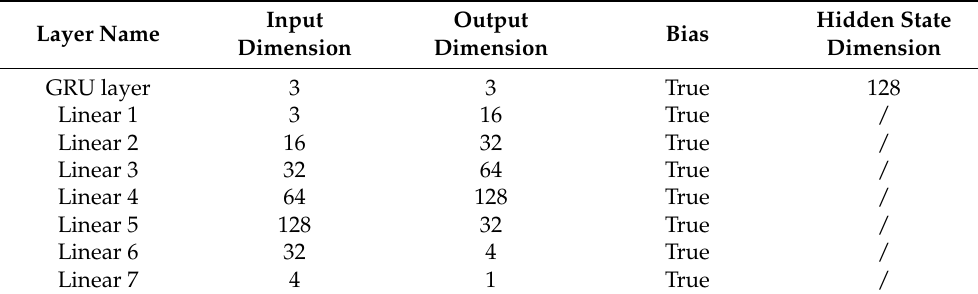
Figure 14. PEA-RNN Structure Diagram. Table 1. RNN Specific Structure